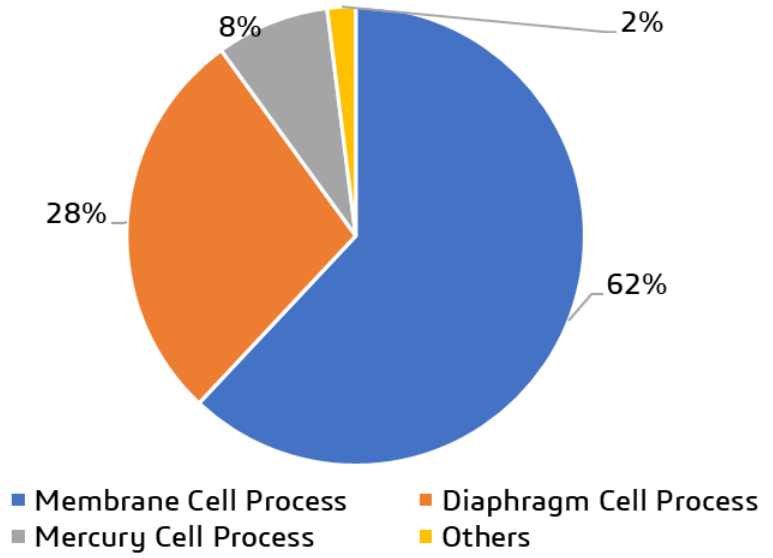
Figure 3. The division of capacity among the three principal cell technologies used in the world for chlor-alkali process [5].